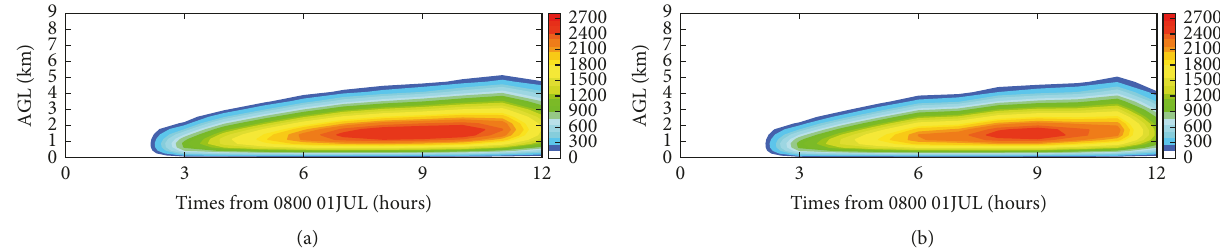
Figure 7: Time-height cross-section of the Eddy Viscosity km at Tazhong station from (a) YSU and (b) Shin-Hong